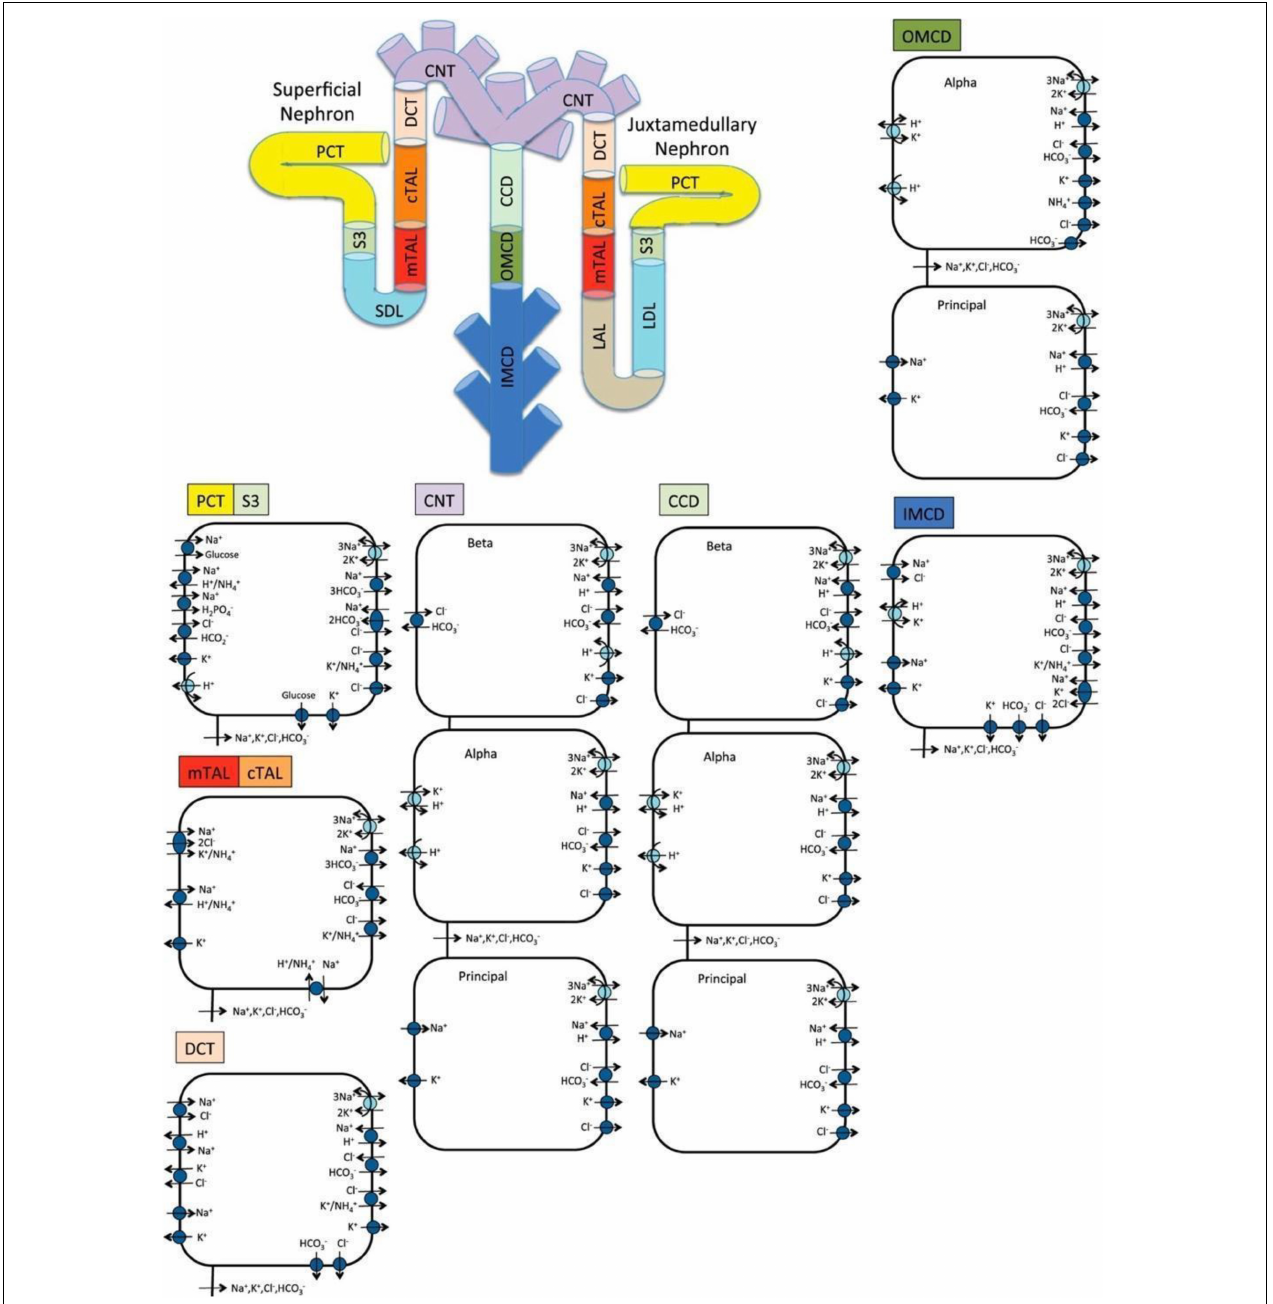
FIGURE 1 | Schematic diagram of the nephron system (not to scale). The model includes 1 representative superficial nephron and 5 representative juxtamedullary nephrons, each scaled by the appropriate population ratio. Only the superficial nephron and one juxtamedullary nephron are shown. Along each nephron, the model accounts for the transport of water and 15 solutes (see text). The diagram displays only the main Na + , K + , and Cl – transporters. mTAL, medullary thick ascending limb; cTAL, cortical thick ascending limb; DCT, distal convoluted tubule; PCT, proximal convoluted tubule; CNT, connecting duct; CCD, cortical collecting duct; SDL, short or outer-medullary descending limb; LDL/LAL, thin descending/ascending limb; OMCD, outer-medullary collecting duct; IMCD, inner-medullary collecting